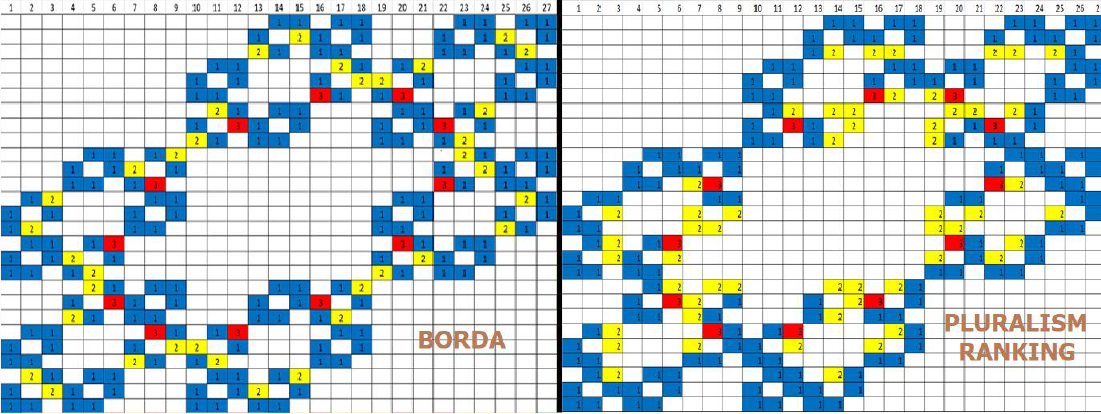
Figure 13. Comparison between the color maps (or heatmaps) for the Borda and pluralism ranking methods for n = 3.